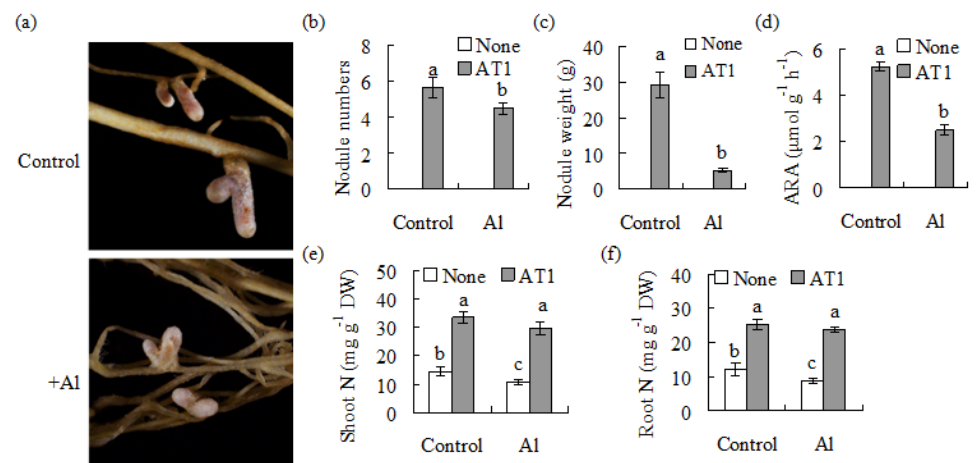
Figure 4. Analysis of the nodulation and plant total nitrogen in alfalfa caused by AT1 under Al stressed conditions. AT1 suspension culture in combination with 1 mM AlCl 3 , or without AlCl 3 as a control, was rhizospherically applied to seedlings of alfalfa 7 d after germination. The low-nitrogen nutrient was maintained at pH 4.3. Photographs of the nodules were taken after 5 weeks ( a ), followed by measurements of the nodule number ( b ), nodule fresh weight ( c ) and nitrogenase acetylene reduction activity (ARA) ( d ). The shoots ( e ) and roots ( f ) were separately harvested for the measurement of the total nitrogen. The data are means ± SE ( n = 18). The same letter above the column indicates no significant difference at p < 0.05.